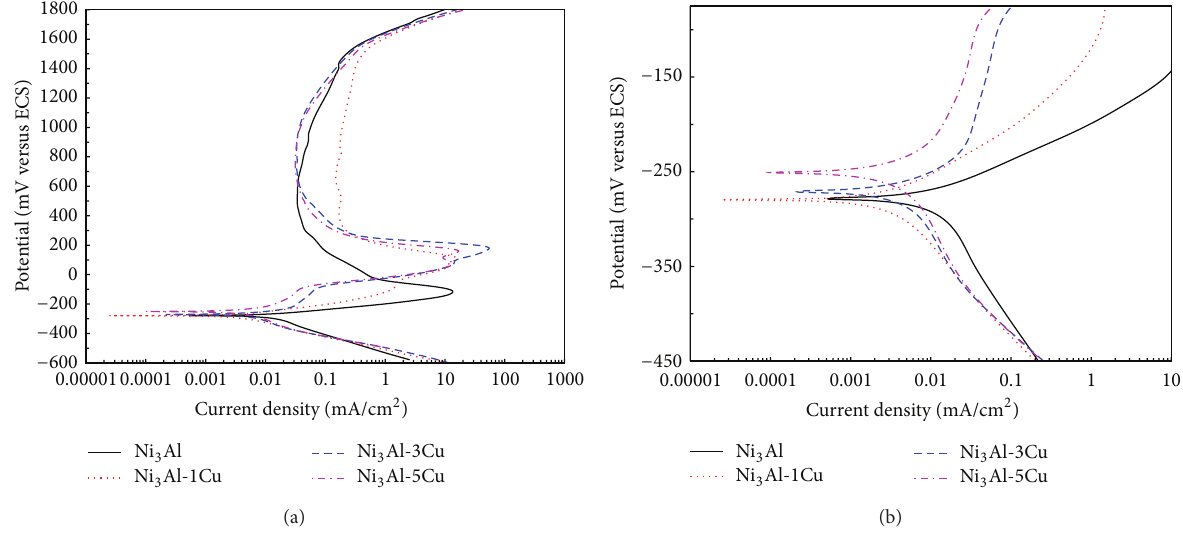
∗ 𝐸 𝑖 pp and pp indicate the primary passivation potential and primary passivation current density. ∗ 𝐸 𝑖 rp and rp indicate the repassivation potential and current density, respectively.